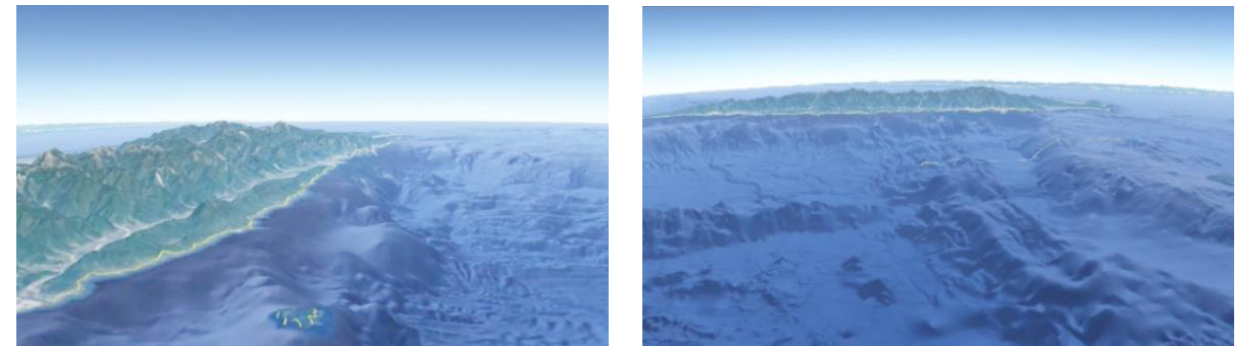
Figure 5. Submarine terrain visualization.